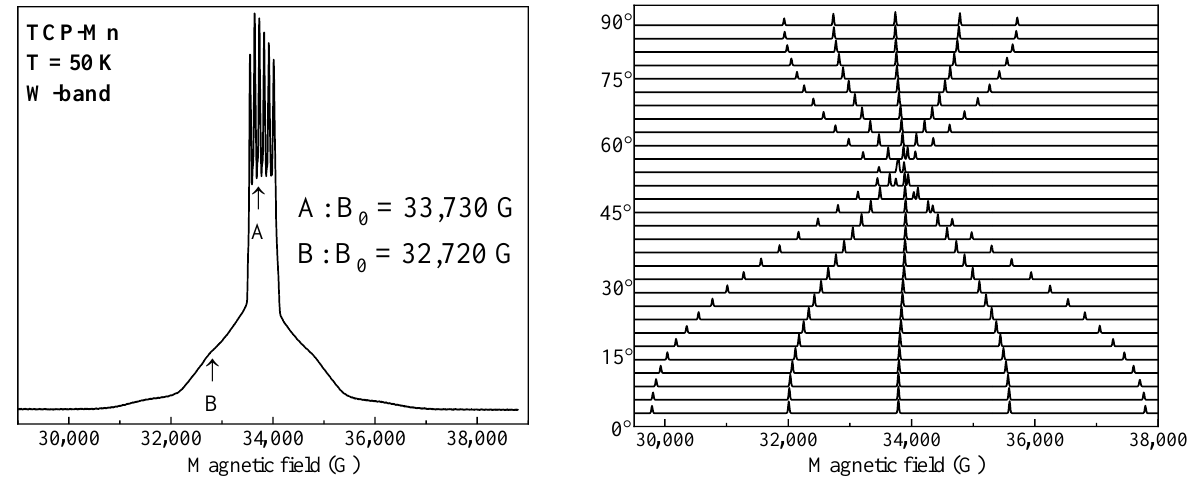
Figure 6. ESE HF-EPR for 0.001MnTCP with registration of all components of the fine structure ( left panel ). Theoretical model of the angular dependence of the components of a fine structure in the W-band ( right panel ).